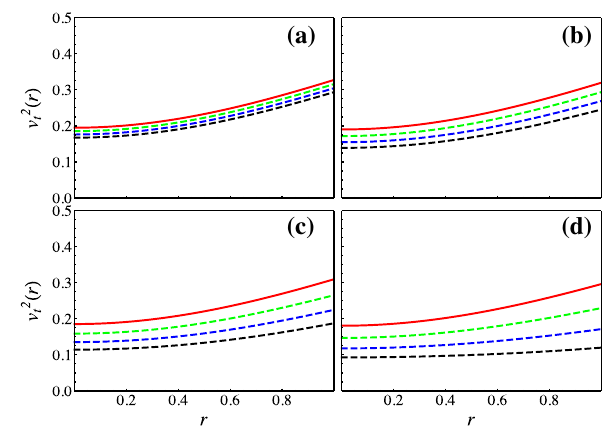
Fig. 8 Tangential velocity v 2 t for M = 0 . 2, R = 1, c 1 = 0 . 5 and a C = − 0 . 1, b C = − 0 . 2, c C = − 0 . 3, d C = − 0 . 4. α = 0 . 1 (red line), α =